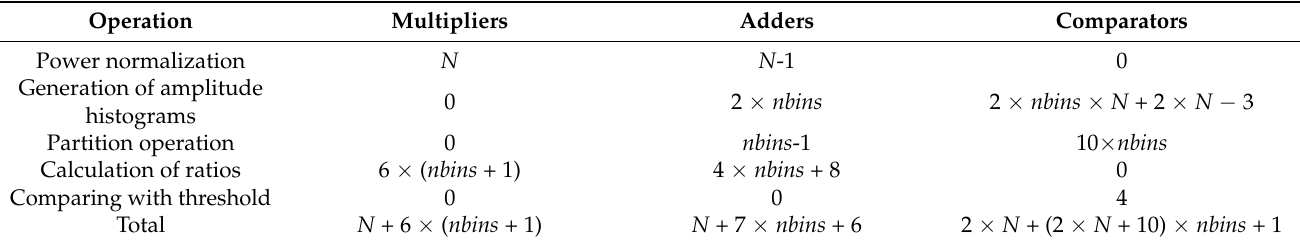
Table 3. Computational complexity of the proposed MFI